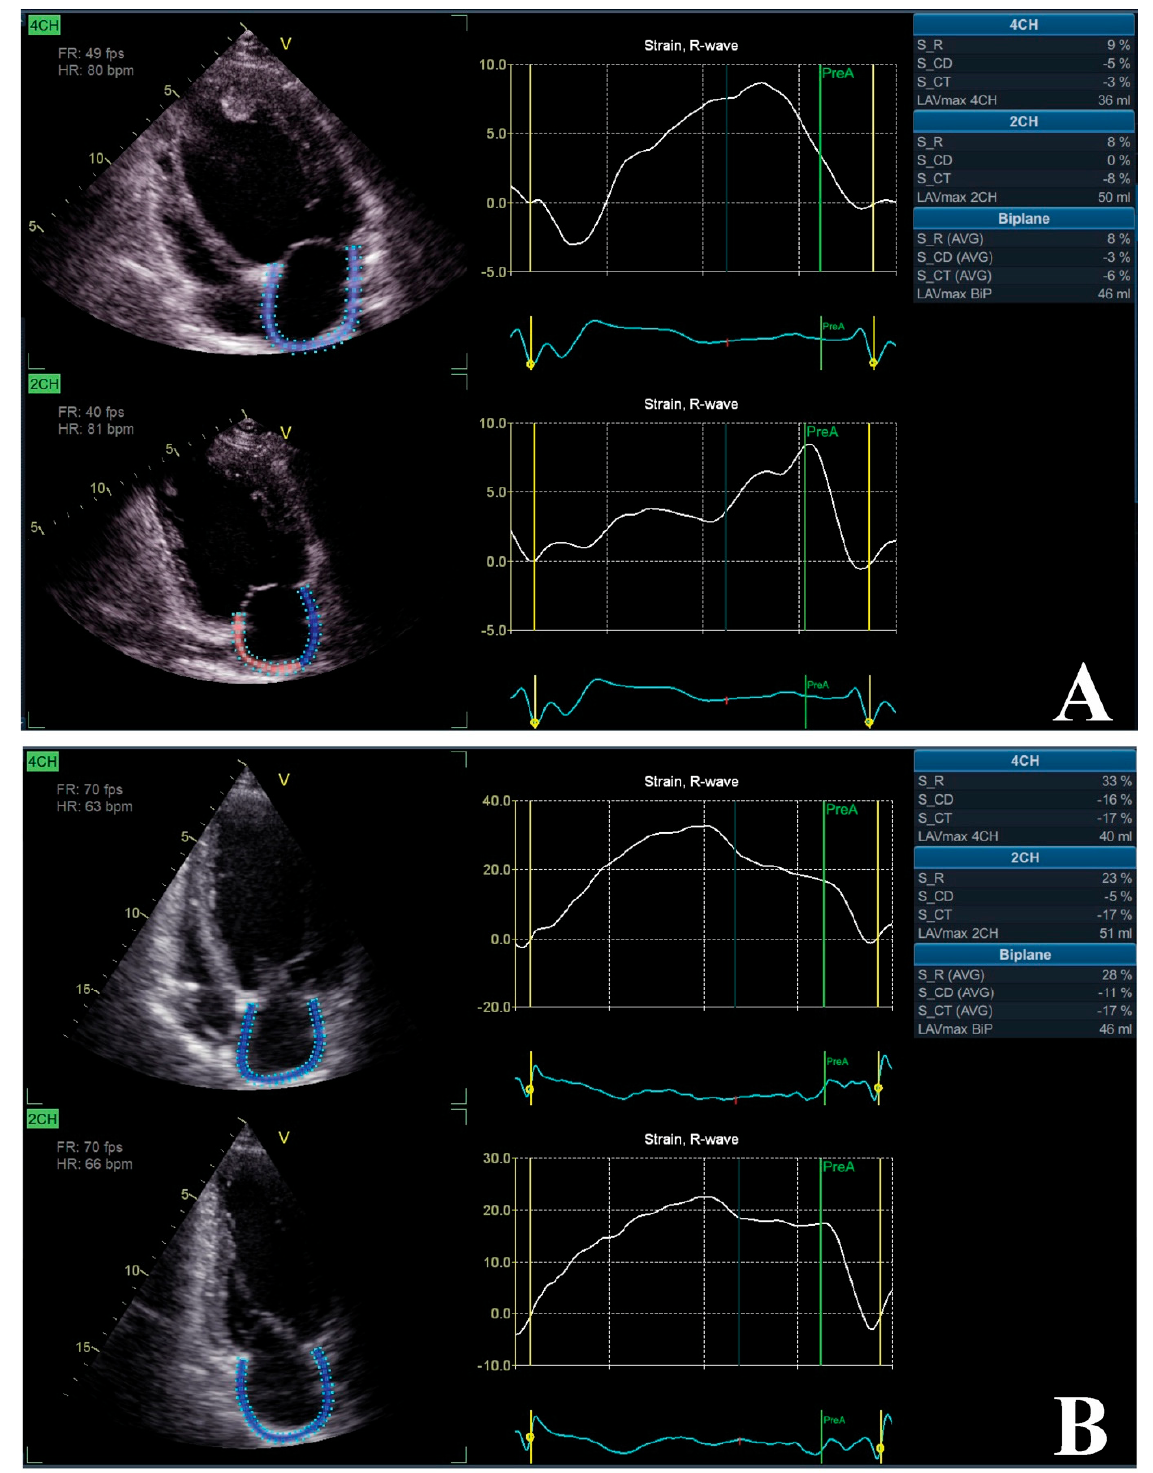
Figure 2. The impact of CRT on LA strain. Patient with dilated cardiomyopathy, LVEF of 33%, and QRS morphology of LBBB with duration of 153 msec. Echocardiographic evaluation using a General Electric VIVID E95 vendor and EchoPac software package to determine LA strains (Images from the personal collection of the authors). Initial evaluation showed impaired LA strains ( A ) and, after a 6-month follow-up, there is significant LA functional reverse remodeling with improved LA strains ( B ). Abbreviations: LA, left atrium; LBBB, left bundle branch block; LVEF, left ventricle ejection fraction.